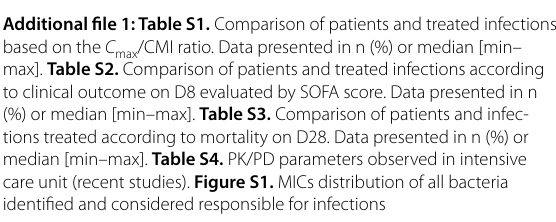
max]. Table S2. Comparison of patients and treated infections according to clinical outcome on D8 evaluated by SOFA score. Data presented in n (%) or median [min–max]. Table S3. Comparison of patients and infec- tions treated according to mortality on D28. Data presented in n (%)